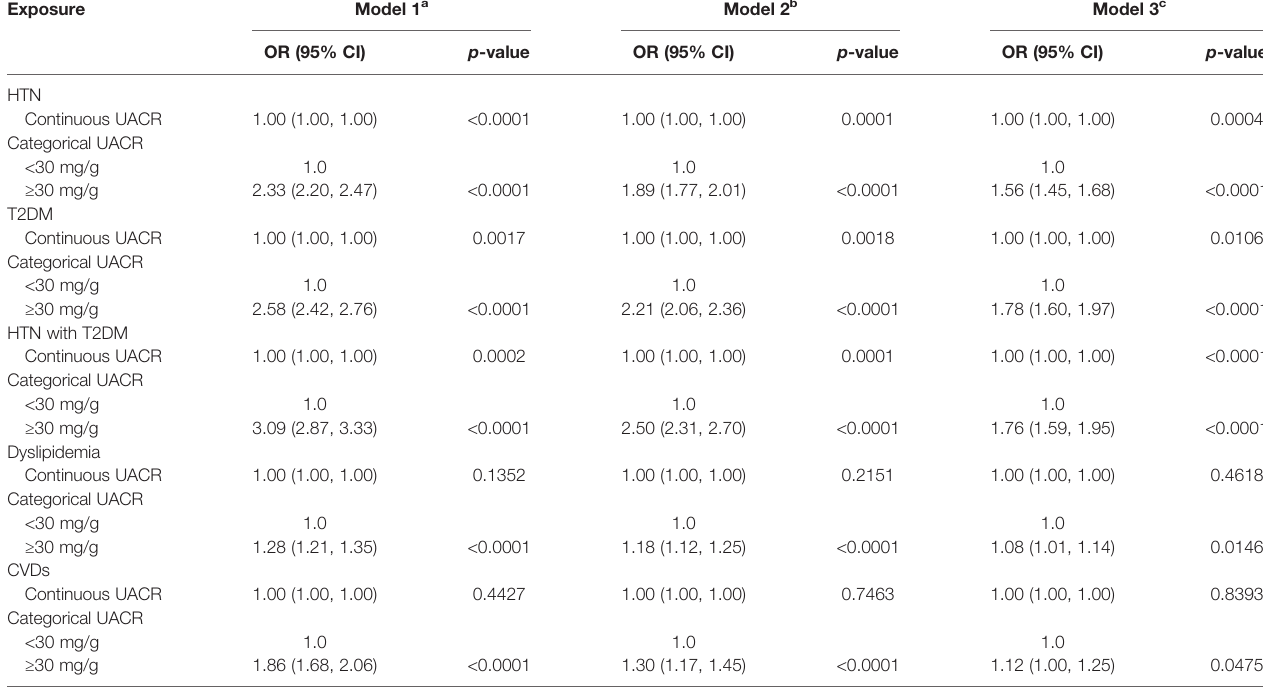
TABLE 2 | Associations of UACR with HTN, T2DM, HTN with T2DM, dyslipidemia, and CVDs in the general population. Exposure